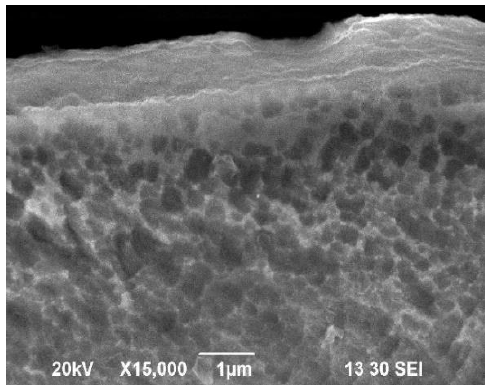
Figure 8. Working surface layer in contact with the abradant (0.29%V, cooling rate within the crystallization interval 4.5 °С/s).